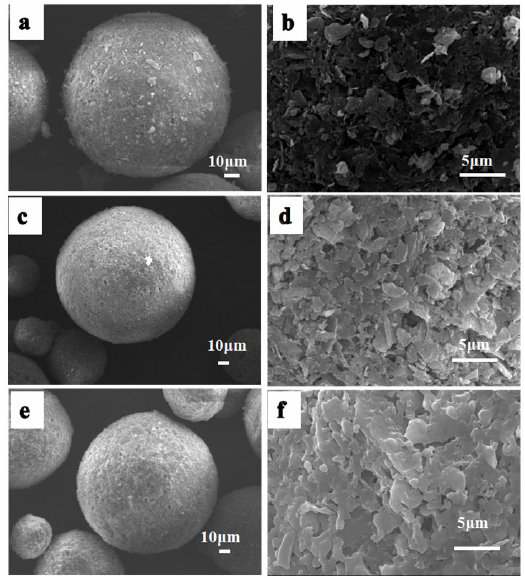
Fig. 6 Typical microstructure of coal gangue microspheres after high temperature treatment at different temperature: (a, b) 800 , d) 900 ℃ and (e, f) 1000 ℃ .